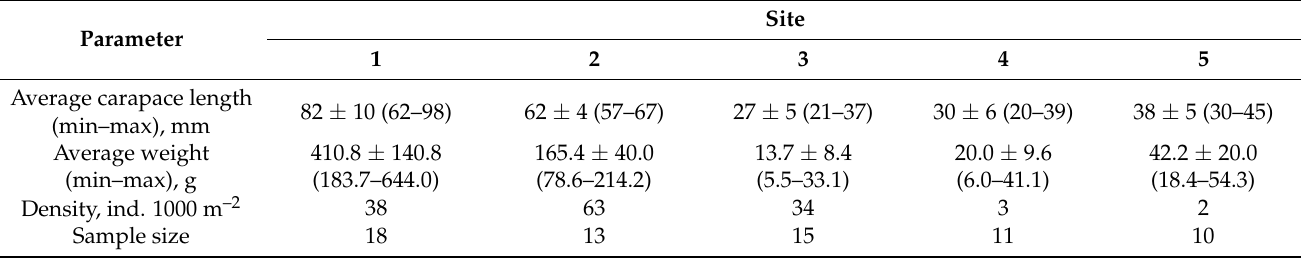
Table 1. Red king characteristics at five sites in Kola Bay, southern Barents Sea.